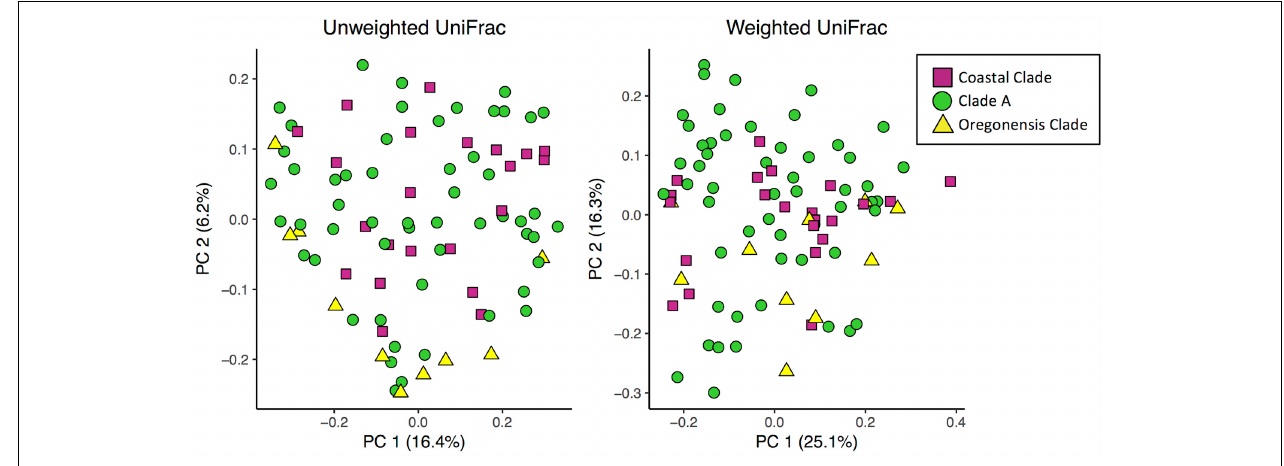
FIGURE 5 | Principle coordinates analysis plots of unweighted and weighted Unifrac distances of Ensatina samples by higher clade groups.